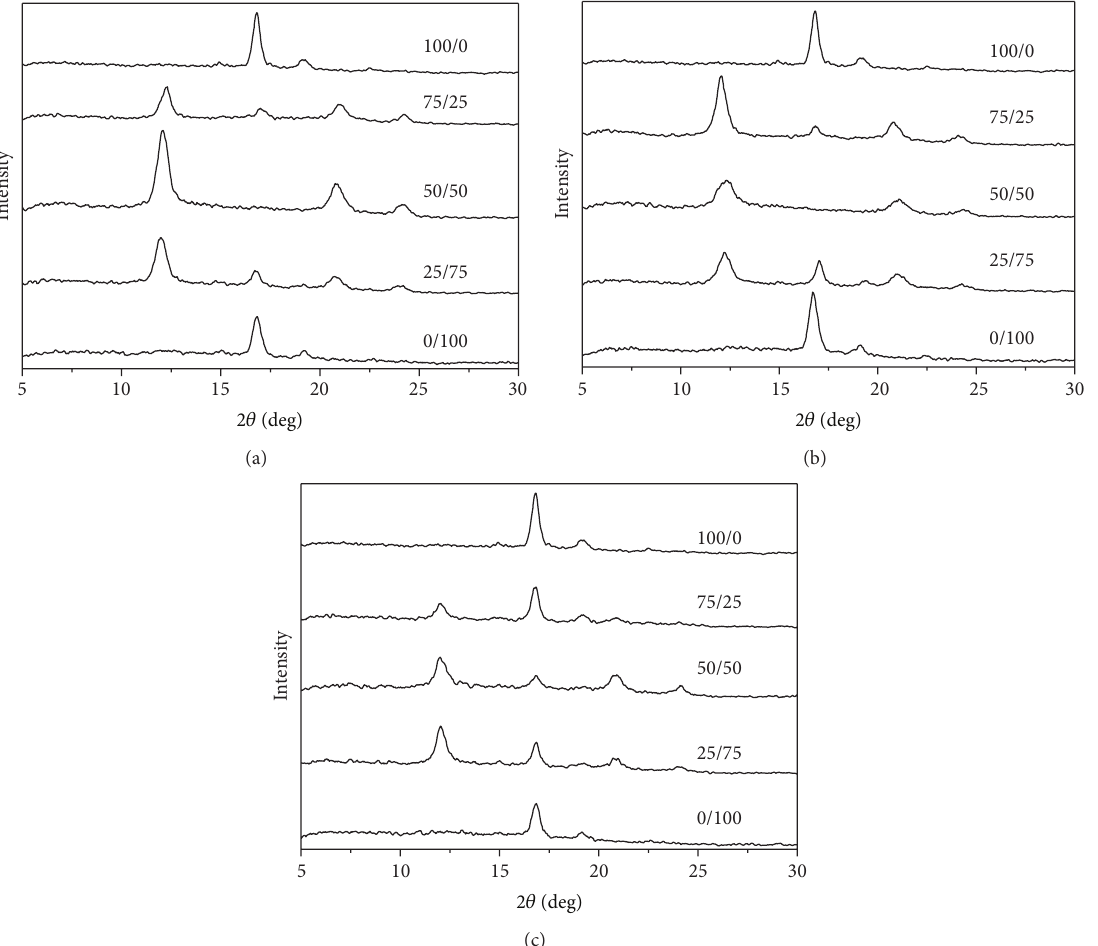
Figure 4: WAXD patterns of (a) 6PLL/1PDL15K, (b) 6PLL/1PDL30K, and (c) 6PLL/1PDL60K stereocomplexes prepared with different 6PLL/1PDL blend